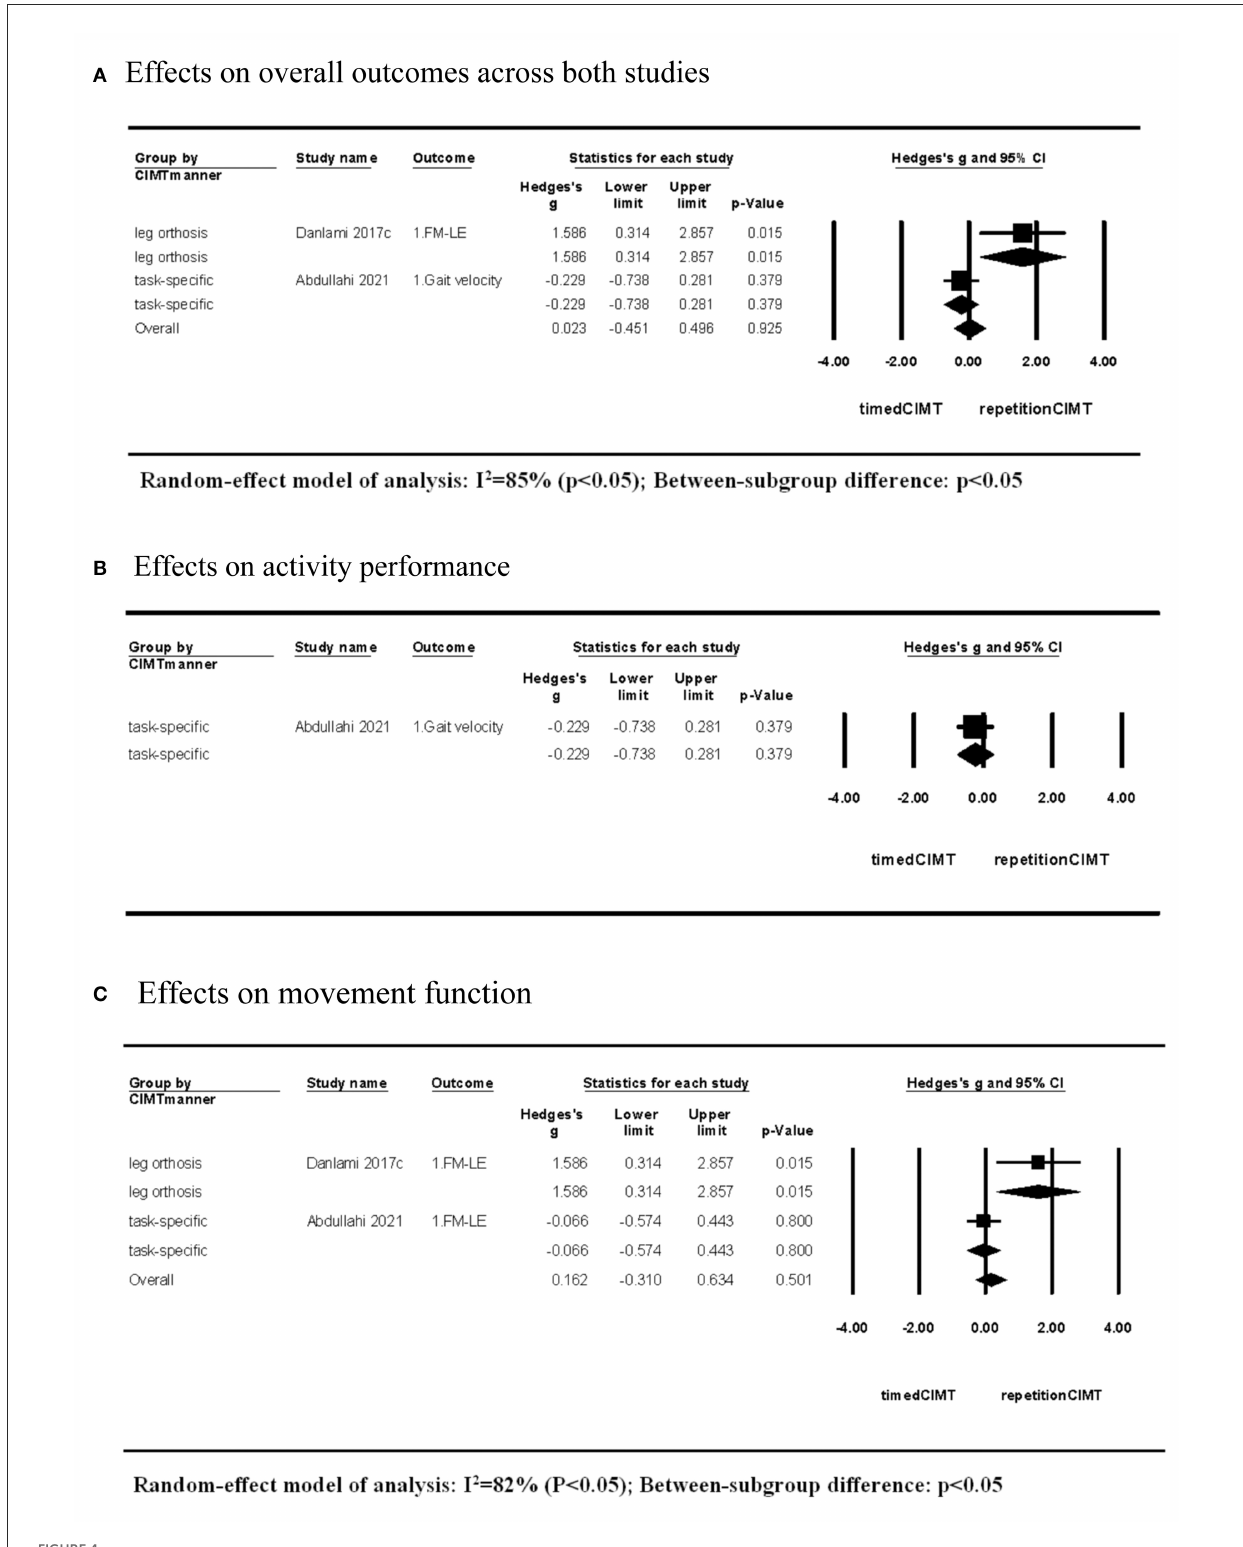
FIGURE4 Short-term effects of CIMT with dosage quantified by repetitions compared with that quantified by time. (A) Effects on overall outcomes across both studies. (B) Effects on activity performance. (C) Effects on movement